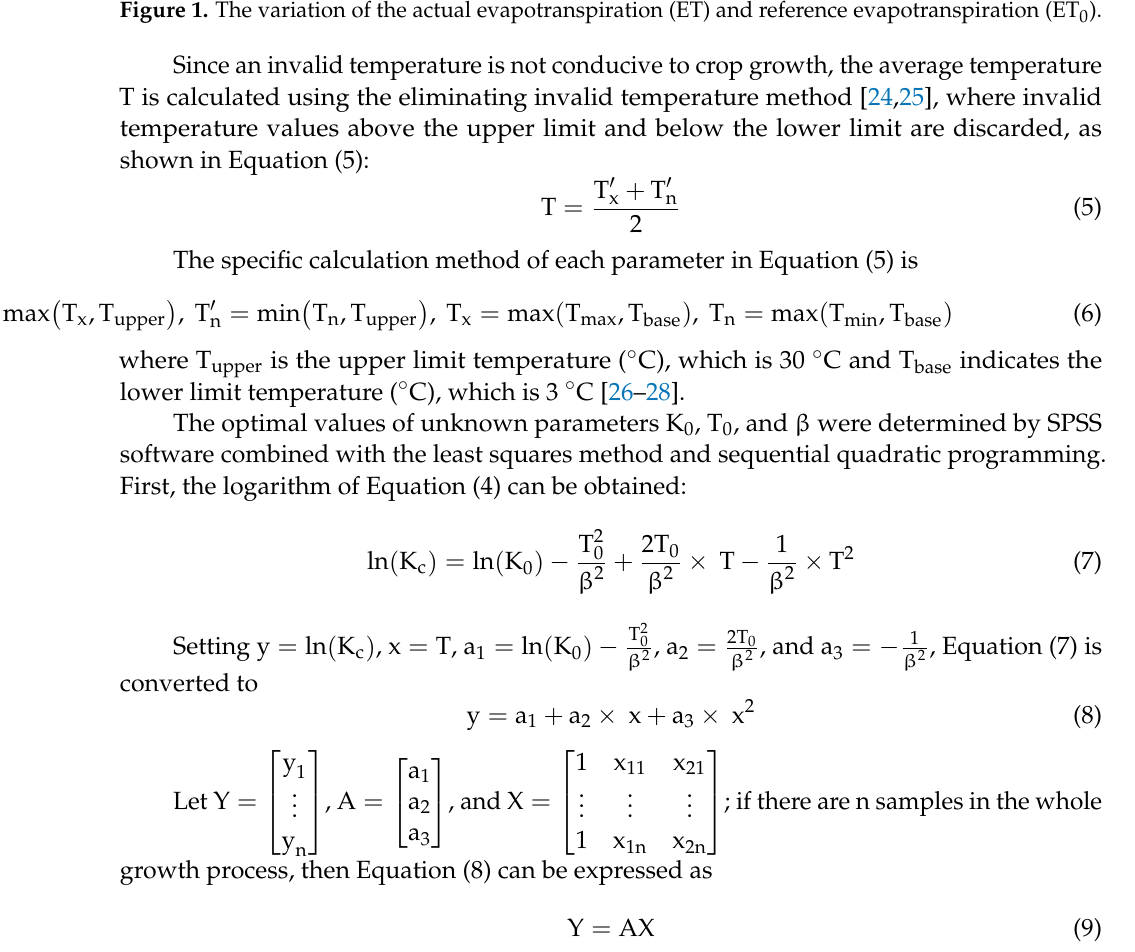
Figure 1. The variation of the actual evapotranspiration (ET) and reference evapotranspiration (ET 0 ).